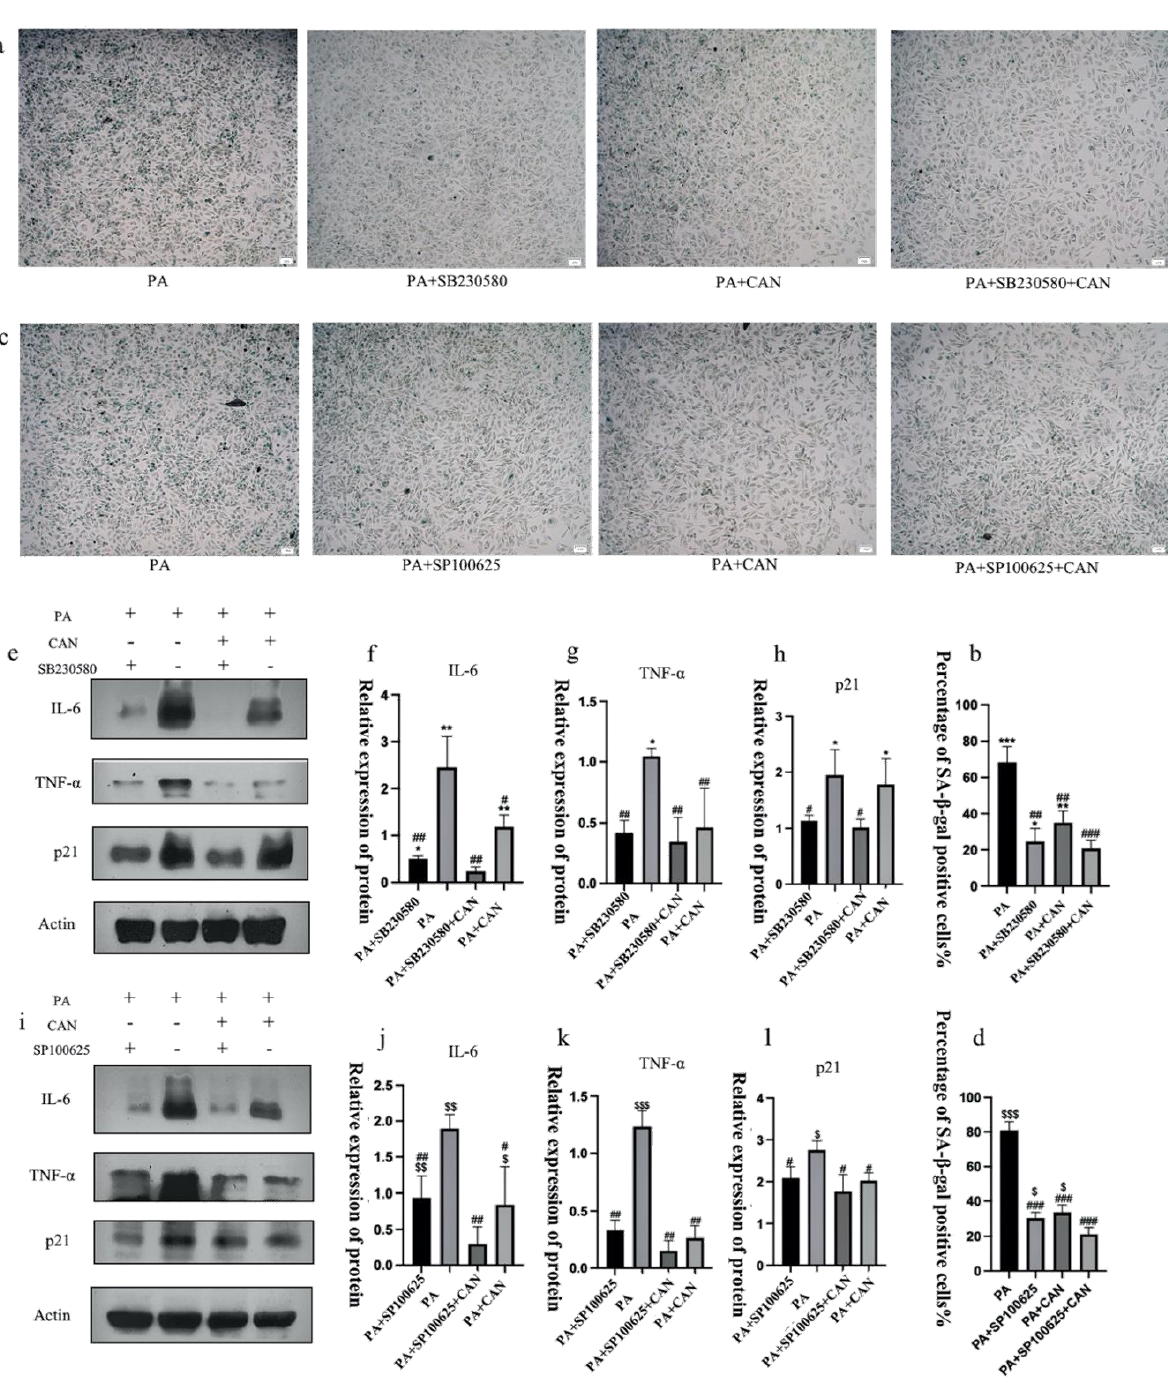
Figure 10. CAN delays PA - induced HUVEC cell senescence by inhibiting p38/JNK activation. ( a , b ) The combination of SB230580 (10 µM) and CAN (5 µg/mL) further reduced the number of β - galactosidase staining - positive cells. ( c , d ) The combination of SP100625 (10 µM) and CAN (5 µg/mL) further reduced the number of β - galactosidase staining - positive cells. ( e – h ) The combina- tion of SB230580 (10 µM) and CAN (5 µg/mL) further reduced SASP factors IL - 6, TNF - α and p21. ( i – l ) SP100625 (10 µM) in combination with CAN (5 µg/mL) further reduced SASP factors IL - 6, TNF - α and p21. Data are expressed as the means ± SD ( n = 3); * p < 0.05, ** p < 0.01, *** p < 0.001 vs. PA + SB + CAN; $ p < 0.05, $$ p < 0.01, $$$ p < 0.001 vs. PA + SP + CAN; # p < 0.05, ## p < 0.01, ### p < 0.001 vs. PA. All images are magnified to 100 ×